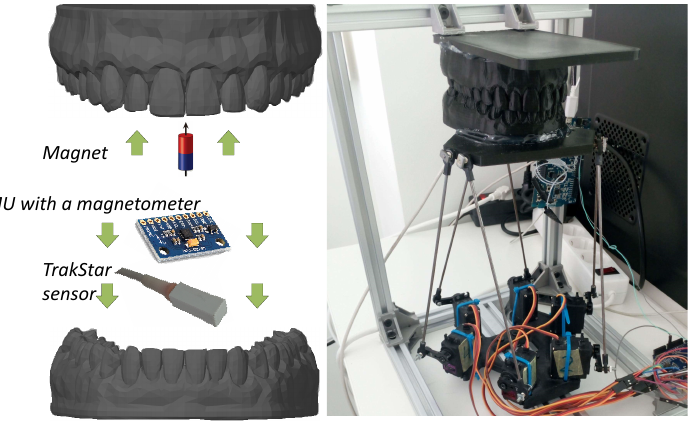
Figure 6. Experimental setup for the general system test using a Stewart